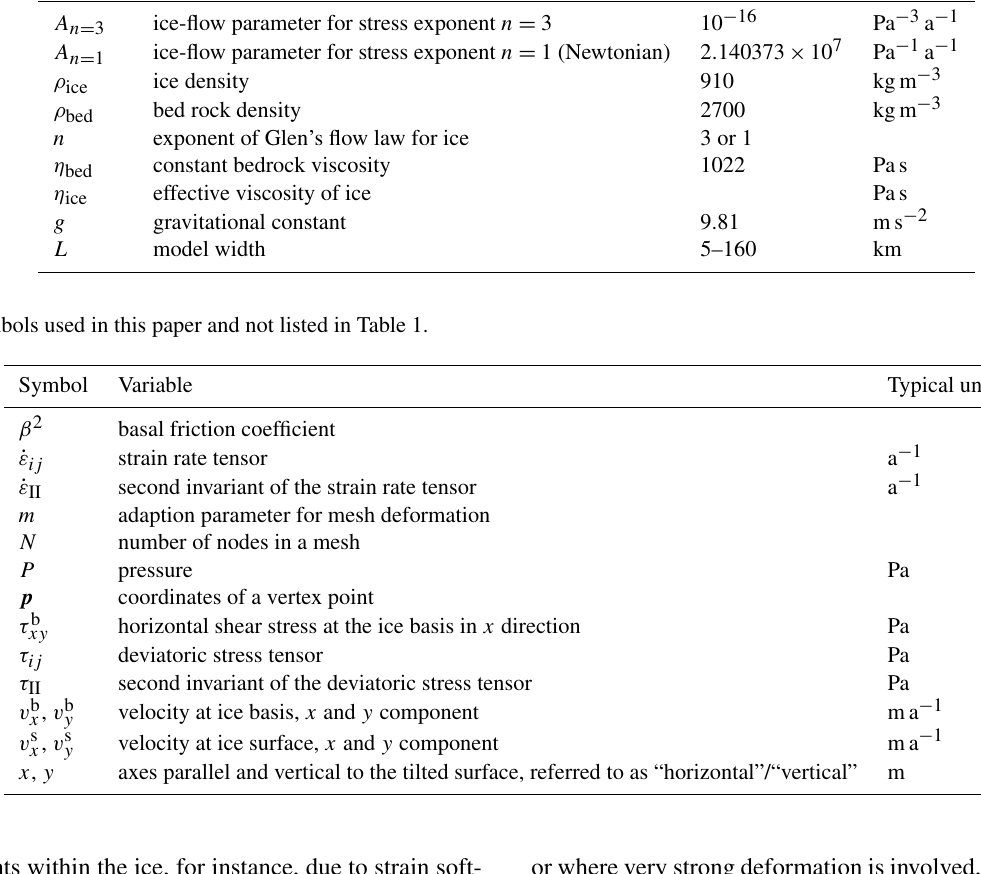
Table 1. Parameters and their values, as prescribed by Pattyn et al. (2008) for the intercomparison project. Symbol